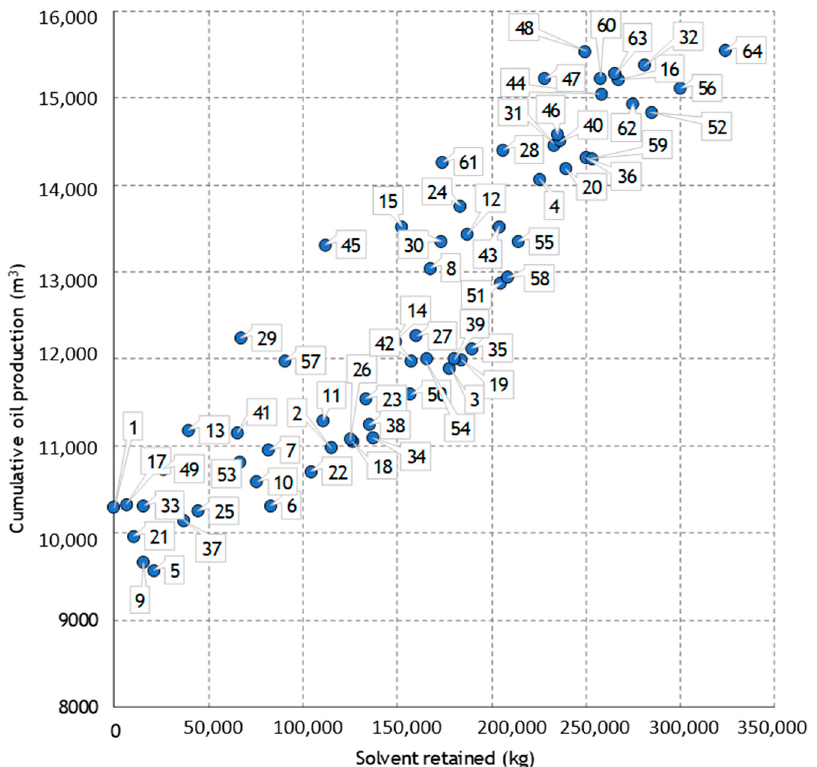
Figure 13. Cumulative oil production in relation to the amount of solvent retained in the reservoir at the end of the simulation for cyclic ES-SAGD with different cycle’s duration. All cases contain hexane at 10% mole. The cycle’s duration for each case is reported in Table A1.